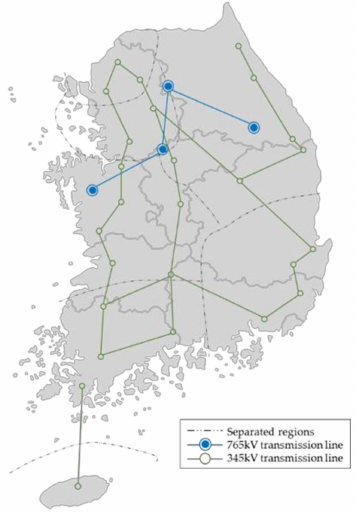
Figure 6. Power grids including seven regions in South